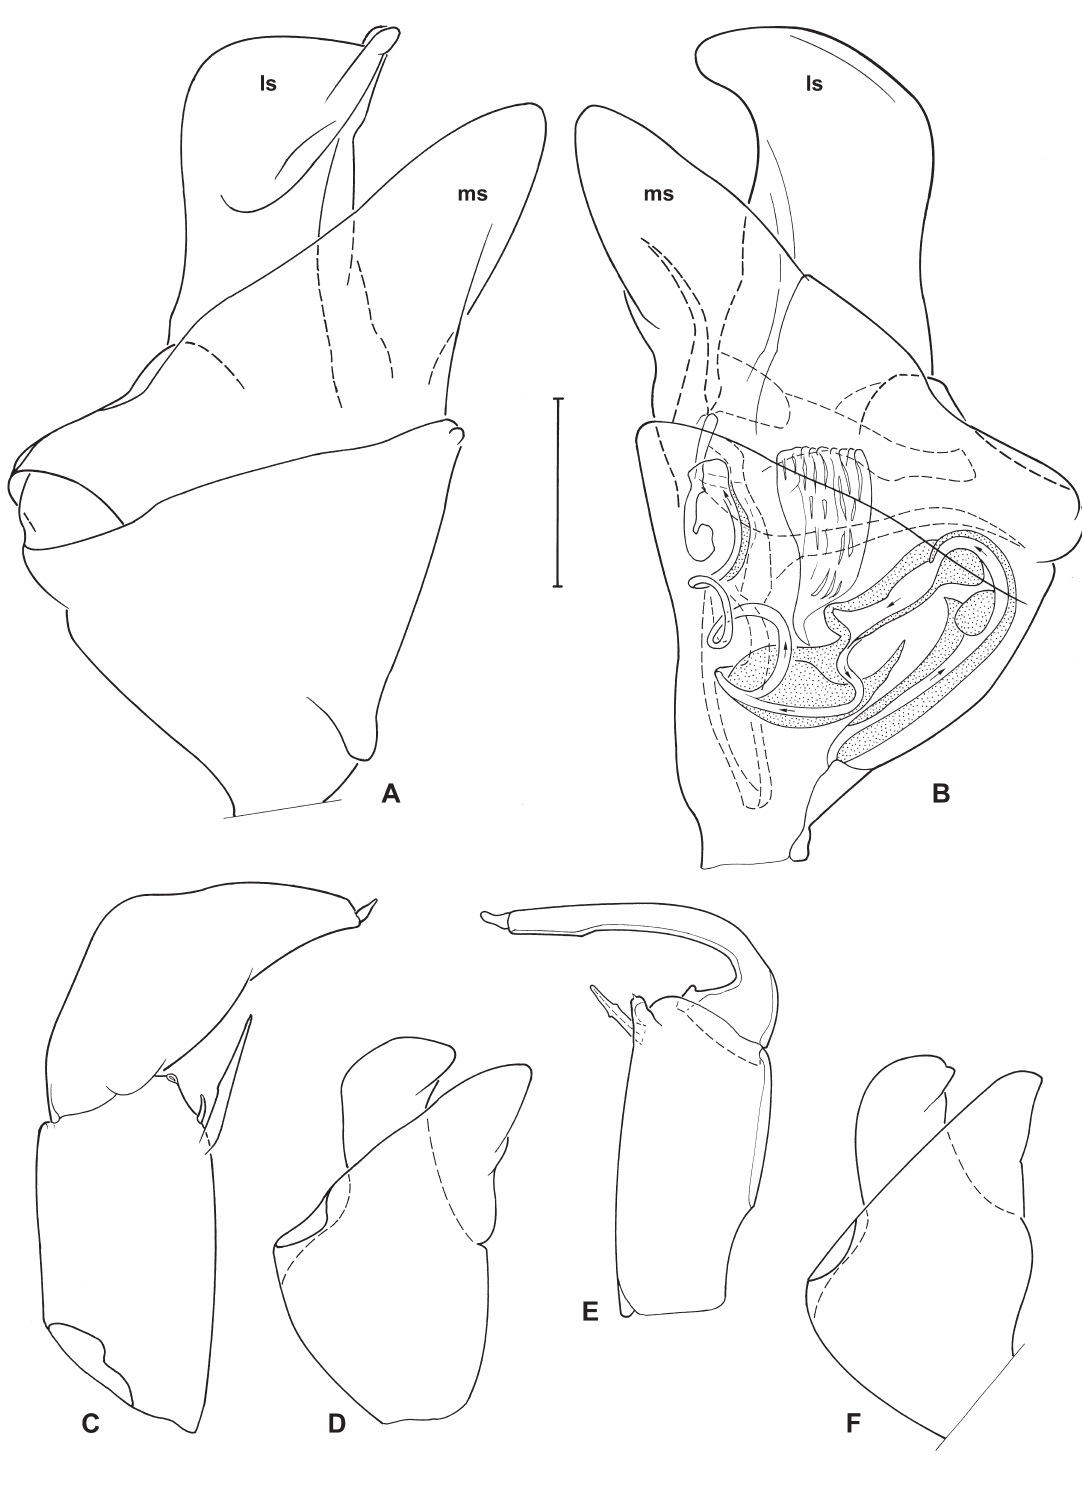
Fig. 14. A - B . Bennelongia coondinerensis sp. nov. (holotype ♂, WAM.C49389); C-F. Bennelongia gwelupensis sp. nov. (♂, WAM.C49397). A . Hemipenis outline. B . Other hemipenis, showing inner anatomy. C . right prehensile palp. D . Hemipenis outline. E . Left prehensile palp. F . Outline of second hemipenis, same individual. Scales: D, F = 232 µm; A, B, C, E = 92